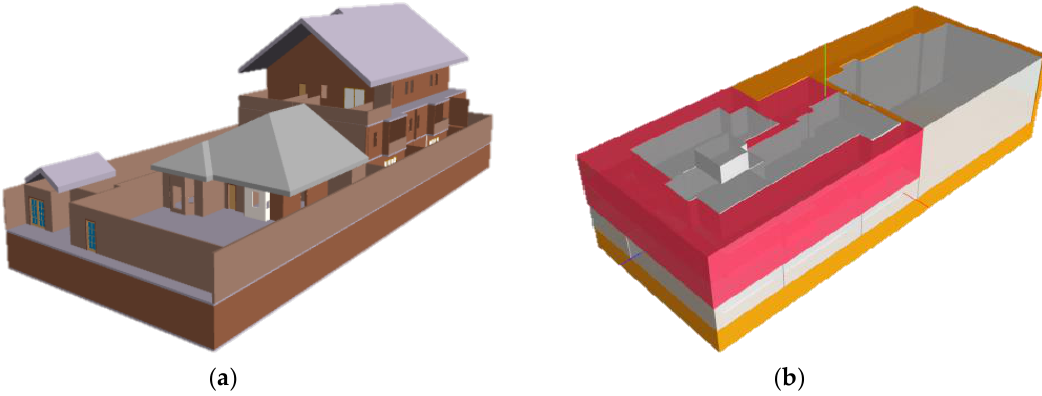
Figure 2. ( a ) A snapshot of the prepared 3D physical model. ( b ) A snapshot of the defined legal model.